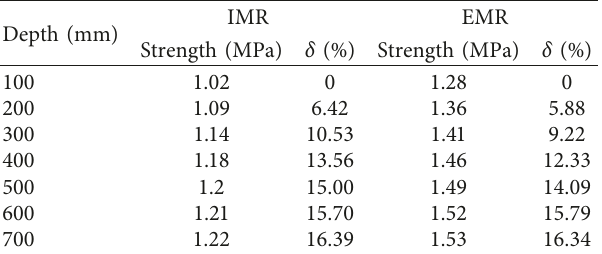
Figure 10: Testing the compressive strength. Table 4: Results of